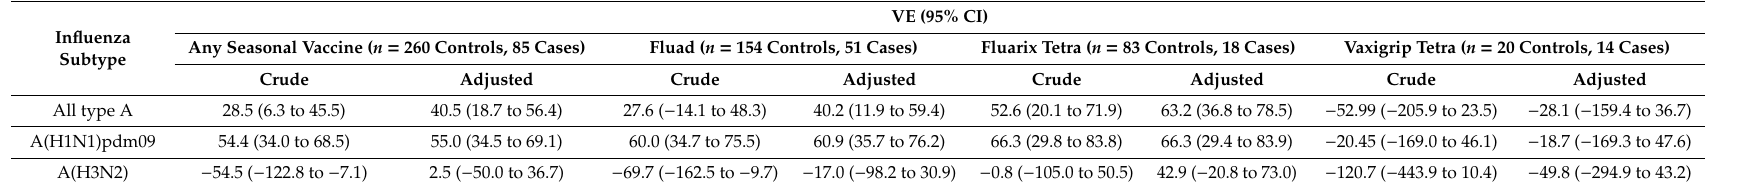
Table 3. Crude and adjusted estimates of vaccine effectiveness (VE), overall and stratified by vaccine brand.